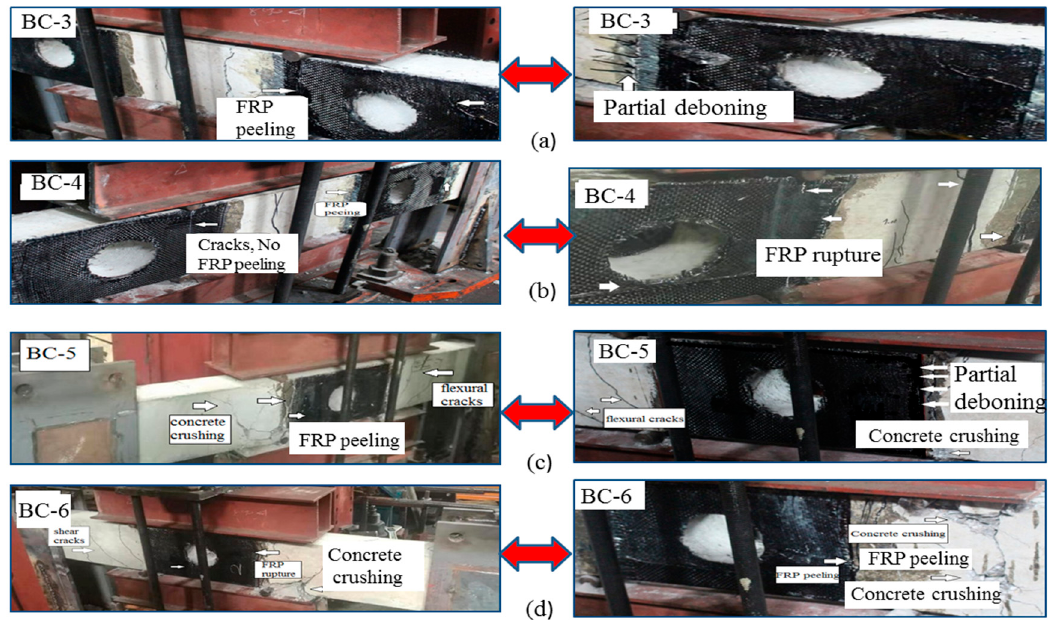
Figure 6. Typically observed failure mode for strengthened beams: ( a ) BC-3, ( b ) BC-4, ( c ) BC-5, ( d ) BC-6. Table 4. Key results of tested